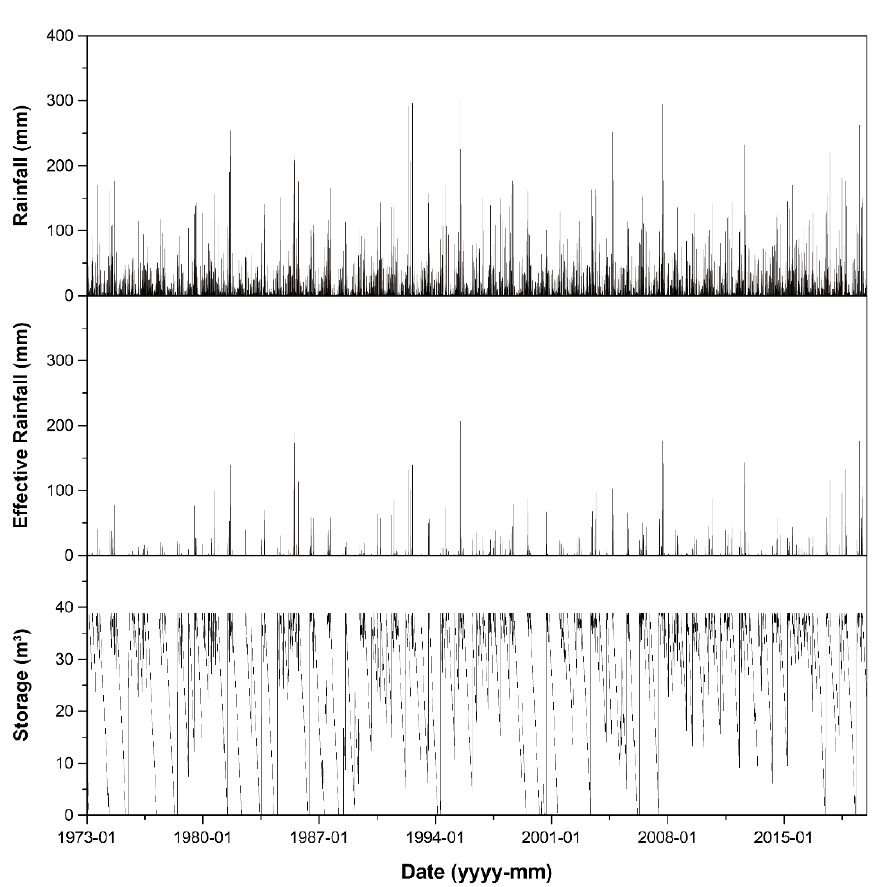
Figure 11. Monthly rainfall, effective rainfall, and water storage estimated for mool-tong #1 by applying the simple water balance model.